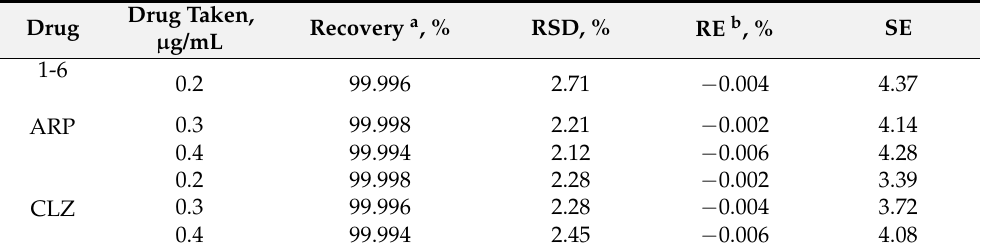
Table 3. Evaluation of inter-day accuracy and precision of the proposed spectrofluorimetric